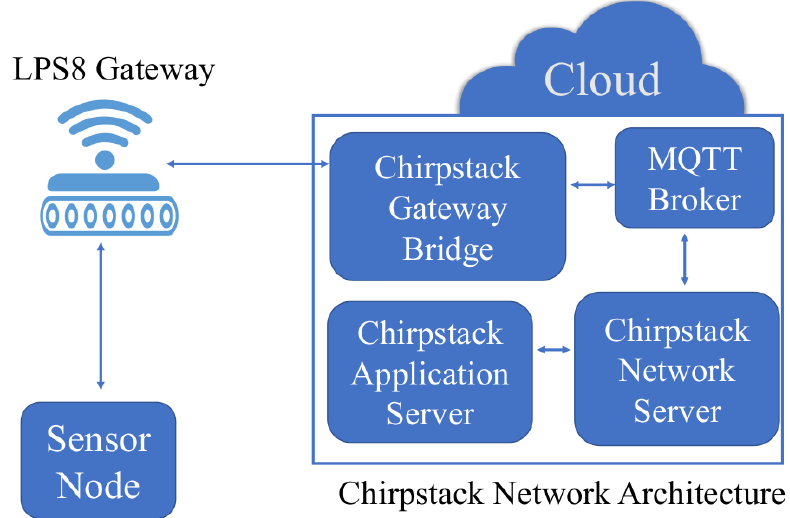
Figure 7. LoRaWAN Infrastructure together with Sensor Node shown in Figure